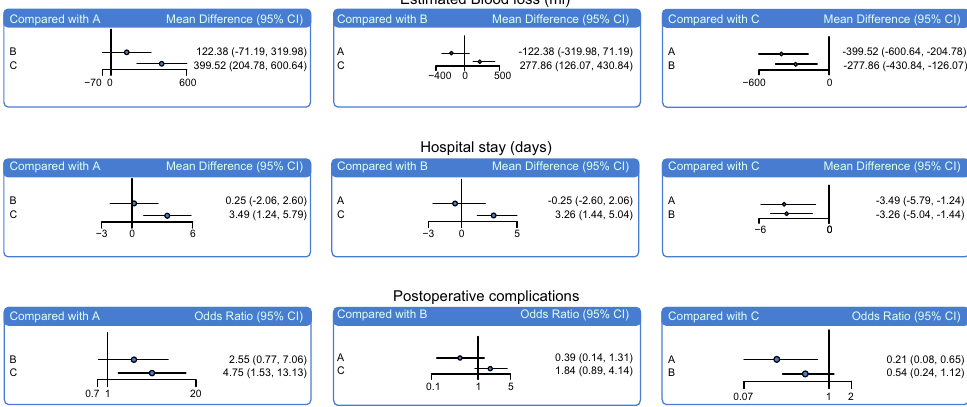
Fig 3. Relative relationship forest plots of estimated blood loss (ml), hospital stay (days) and postoperative complications of RRH, LRH and ORH in the treatment of early-stage CC. Note: A = RRH (robotic radical hysterectomy); B = LRH (laparoscopic radical hysterectomy); C = ORH (open radical hysterectomy).